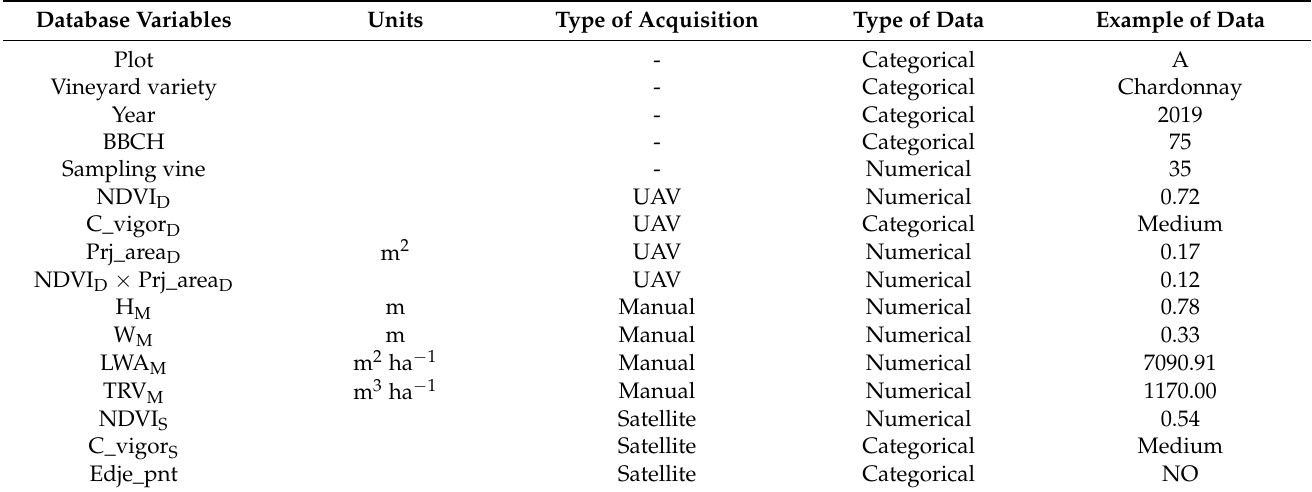
Table 3. Database